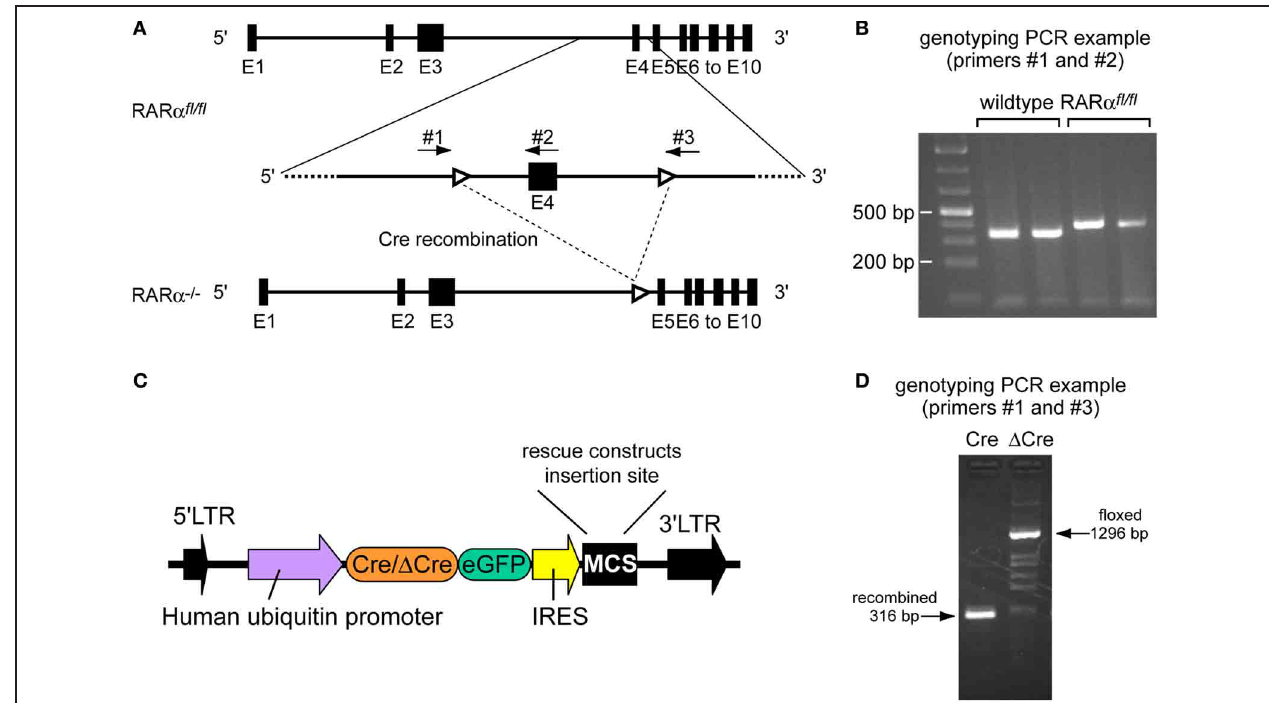
number 2. Wild-type: 390bp; floxed allele: 453bp. (C) Schematic representation of the lentiviral transfer vector used to express Cre-recombinase or (cid:2) Cre and RAR α rescue constructs. (D) DNA from dissociated hippocampal neuronal cultures infected with either the active recombinase Cre or the inactive form (cid:2) Cre was harvested and genotyped by PCR using primers 1 and 3 to test for successful recombination indicated by the presence of a recombined allele (316bp) or of a floxed allele